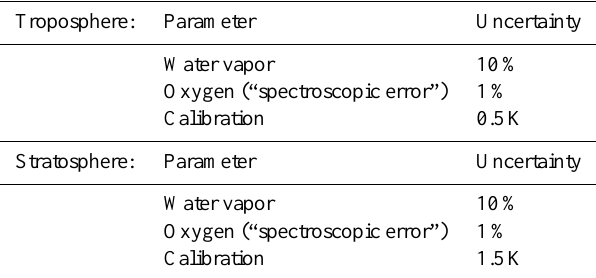
Table 4. Estimated uncertainties for the calculations of the system- atic retrieval errors.